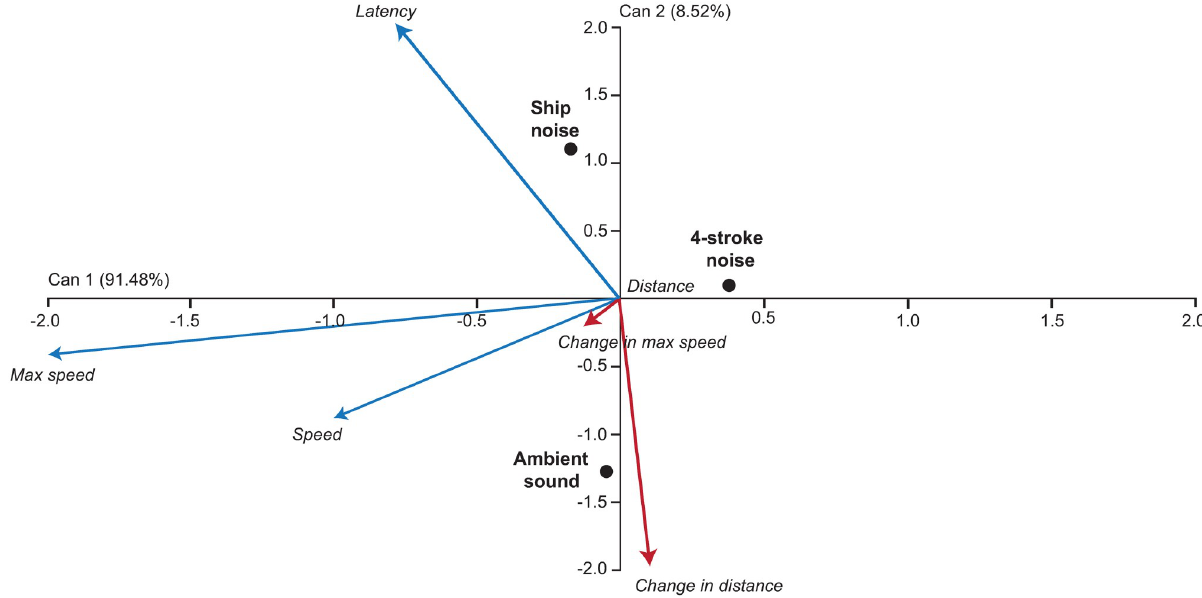
Fig 4. Canonical discriminant analysis. Canonical discriminant analysis displaying how the playback of noise from ships, 4-stroke powered motorboats and ambient affected the routine swimming (red line) and escape response (blue line) of juvenile Pomacentrus chrysurus . A canonical discriminant analysis displays the difference in routine swimming and escape response variables among acoustic treatments. The direction and importance of trends are indicated by the direction and the length of the vectors representing the original variables.